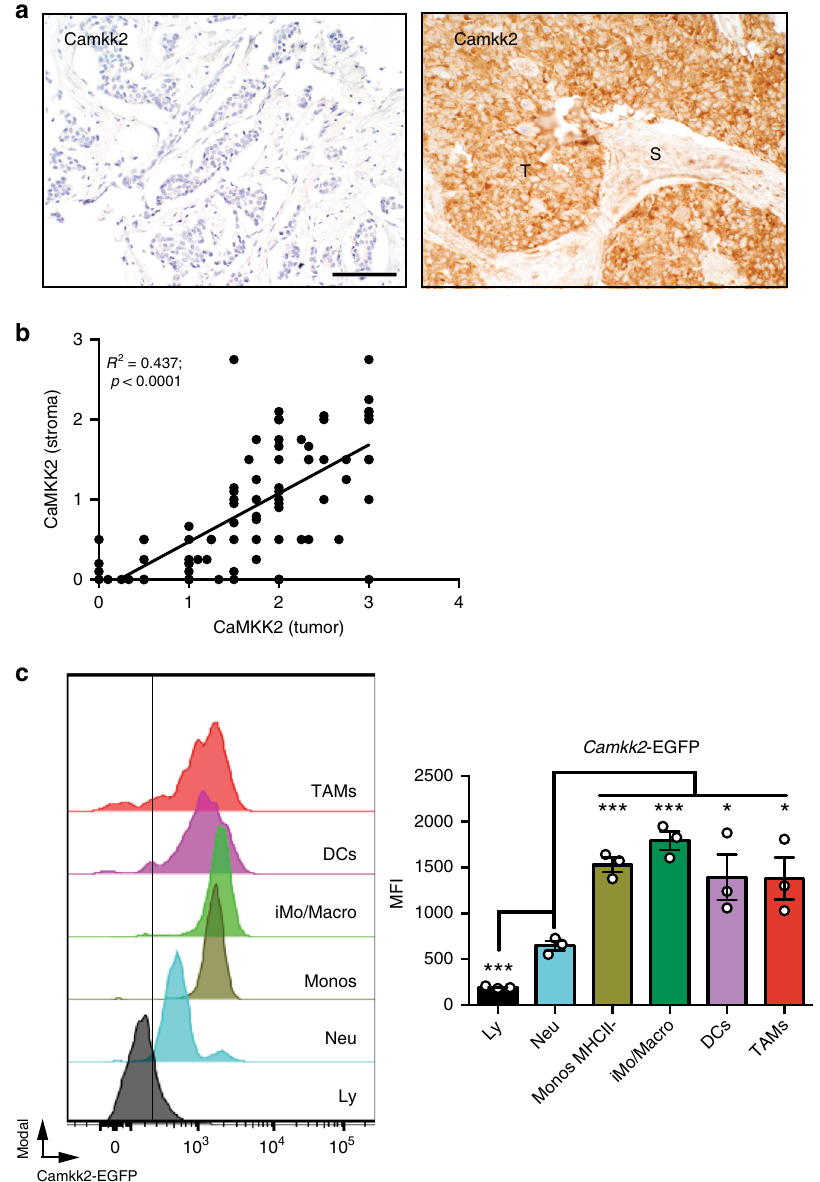
Fig. 1 CaMKK2 is expressed in mammary tumor-associated stromal cells. a Expression of CaMKK2 in human breast cancer. Representative images (×400 magni fi cation) of malignant mammary tissue samples stained with an anti-CaMKK2 antibody. T and S refer to tumor and stromal cells, respectively. Scale bar = 100 μ m. b CaMKK2 staining intensity is correlated between cancer and stromal cells of the same human breast tumors. c The Camkk2 promoter